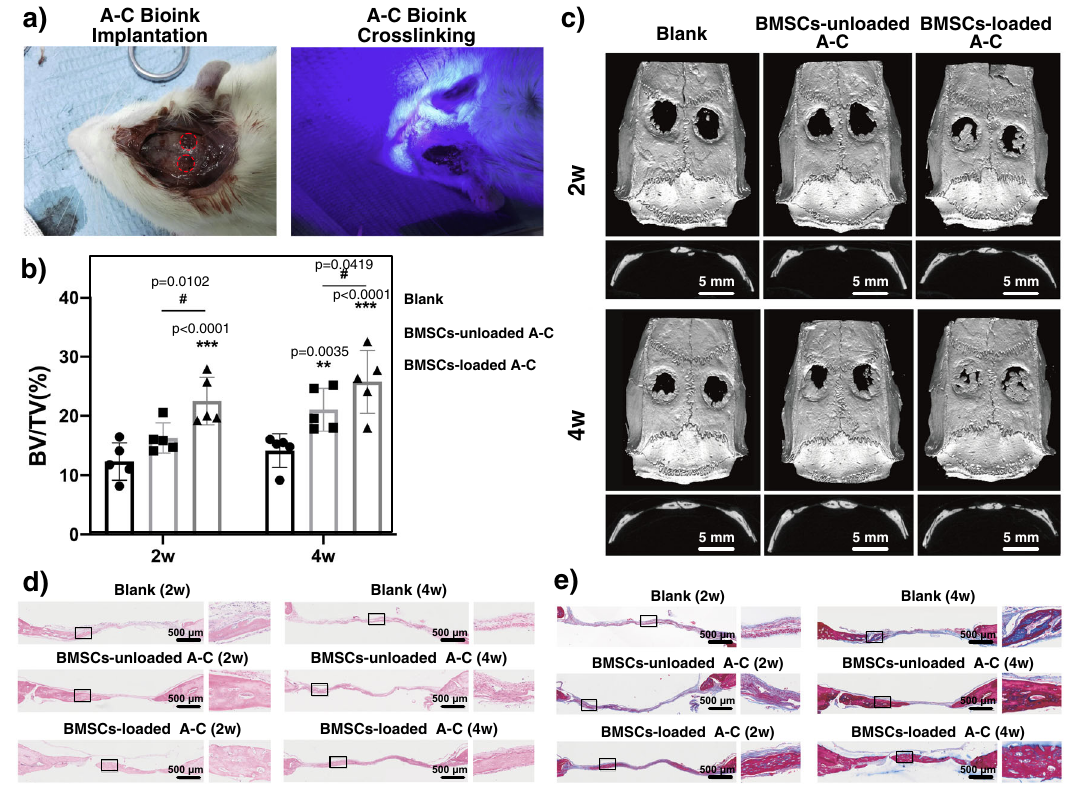
Fig. 7 In-vivo therapeutic effect of A – C bioink at rat cranial defect model. a Implantation and photocrosslinking of A – C bioink at rat cranial defect model. b BV/TV value. ( n = 5 rats. Data are presented as mean value ± SD with GraphPad Prism 8.) Two-sided two-way ANOVA followed by Tukey post hoc multiple comparisons test was used. And statistical test was conducted within 2w groups or 4w groups, respectively, but not done across 2w and 4w groups. c Micro-computed tomography examination. d Histological analysis with H&E staining. e Histological analysis with Masson trichrome staining. For d , e , each experiment was repeated independently with similar results for 3 times.